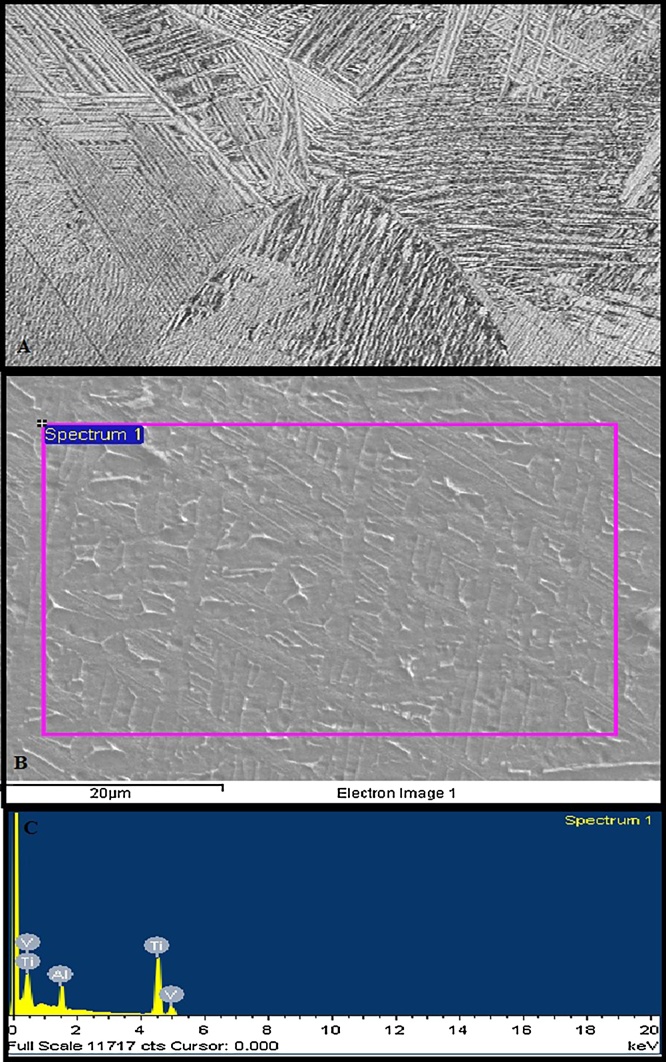
(A) Basket-weave" or Widmanstätten microstructure of homogenized Ti-6Al-4V alloy (100 x). (B) Scanning electron micrograph along with (C) EDAX scan showing that the alloys were composed of selected constituents only.